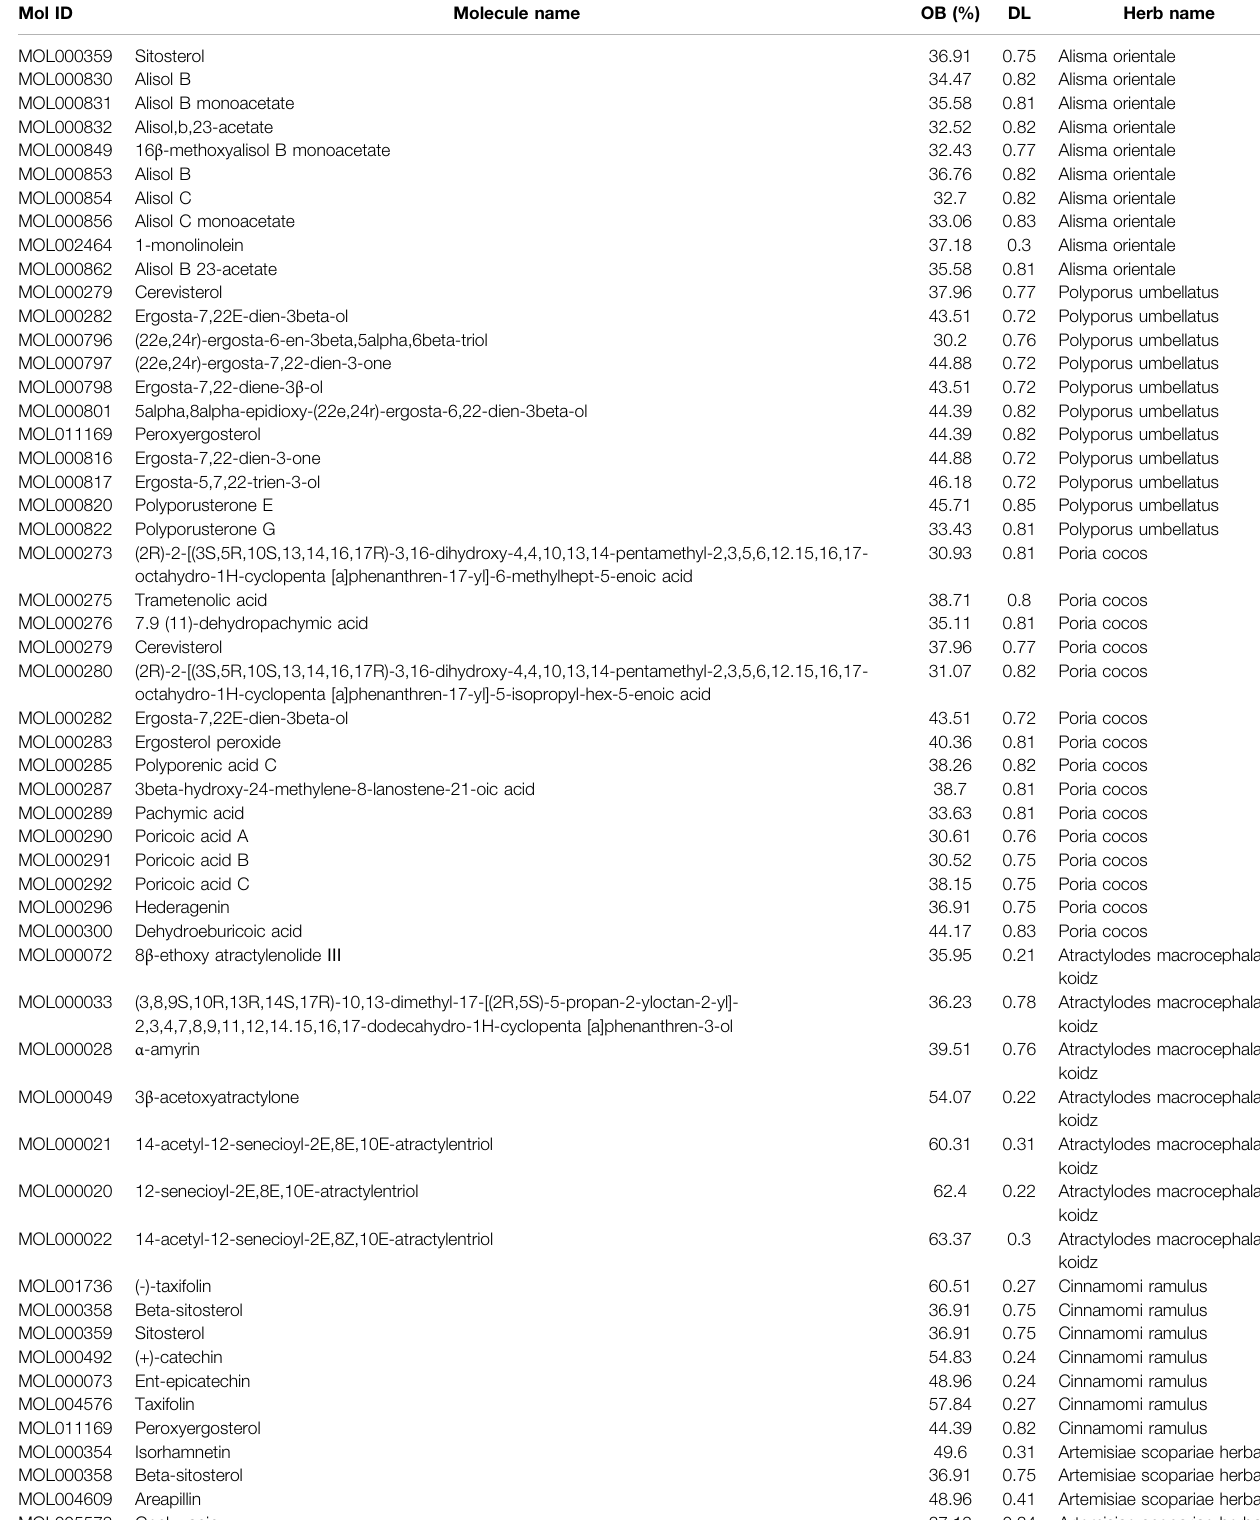
TABLE 1 | Active components of